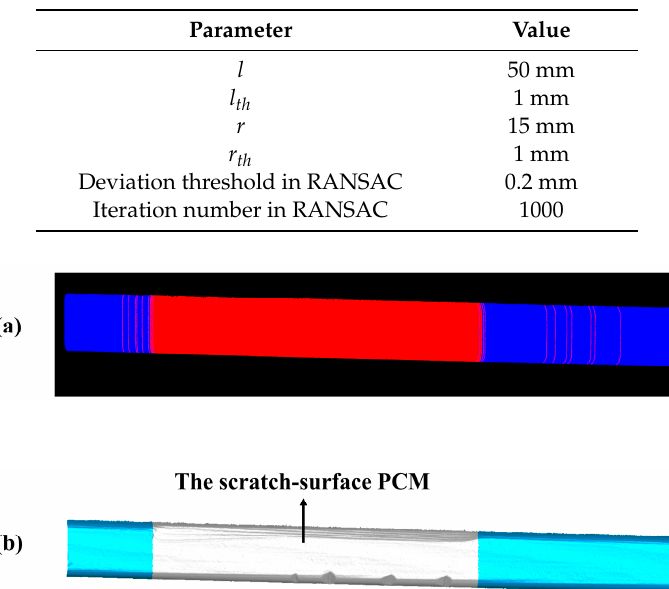
Table 5. The values of the parameters mentioned in Figure 7.